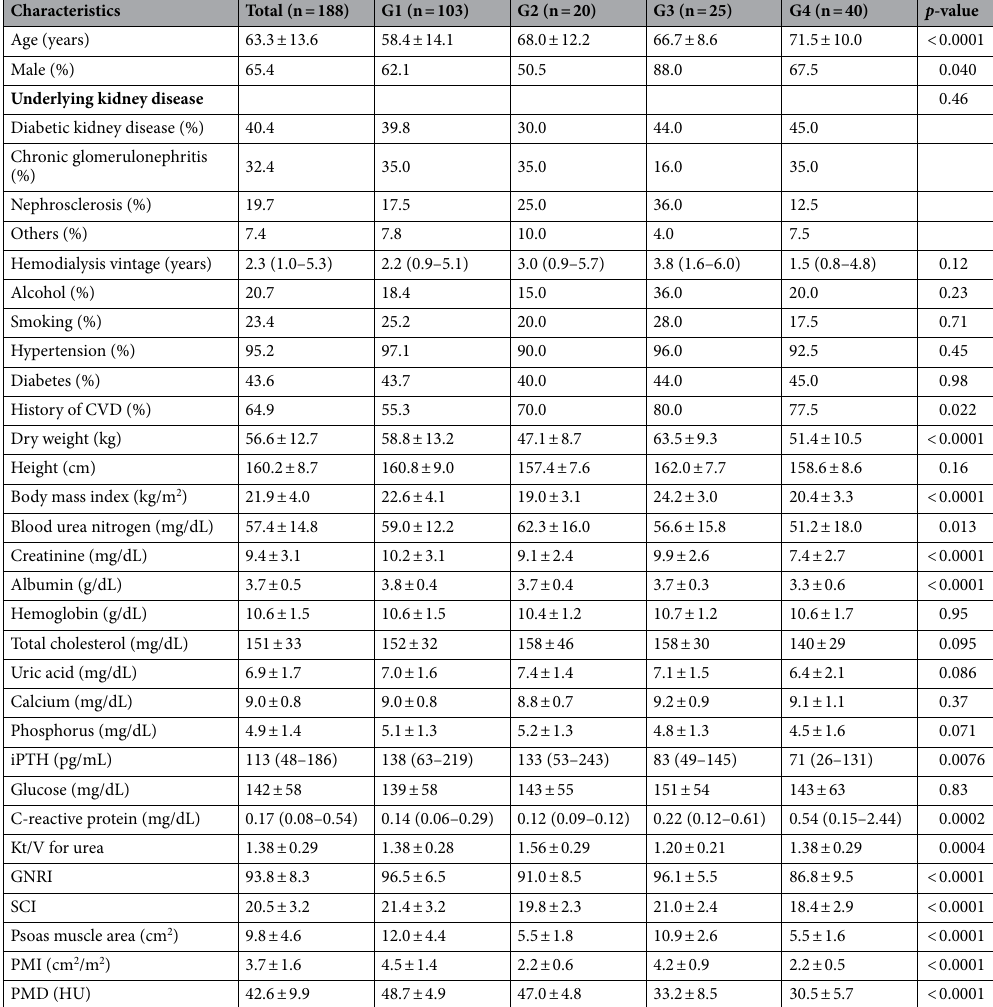
Table 1. Baseline characteristics of the study participants (N = 188). PMI psoas muscle index, PMD psoas muscle density, CVD cardiovascular disease, iPTH intact parathyroid hormone, GNRI geriatric nutritional risk index, SCI simplified creatinine index, G1 higher PMI and higher PMD, G2 lower PMI and higher PMD, G3 higher PMI and lower PMD, G4 lower PMI and lower